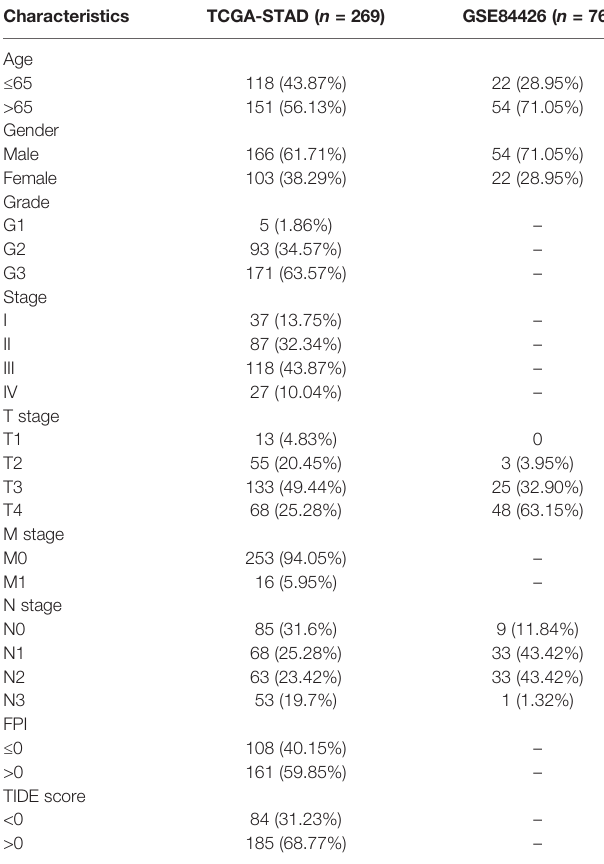
TABLE 1 | Clinical characteristics of the stomach adenocarcinoma patients included in this